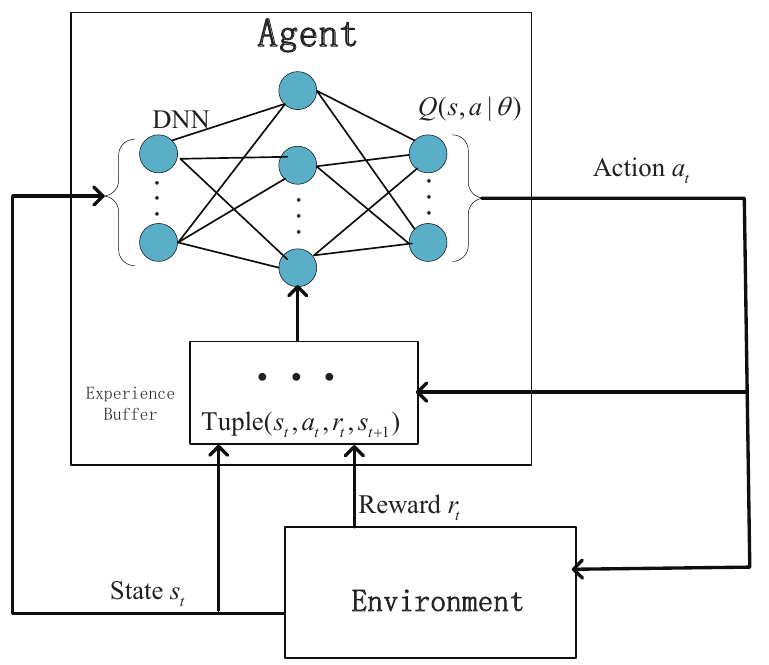
Figure 3. Training